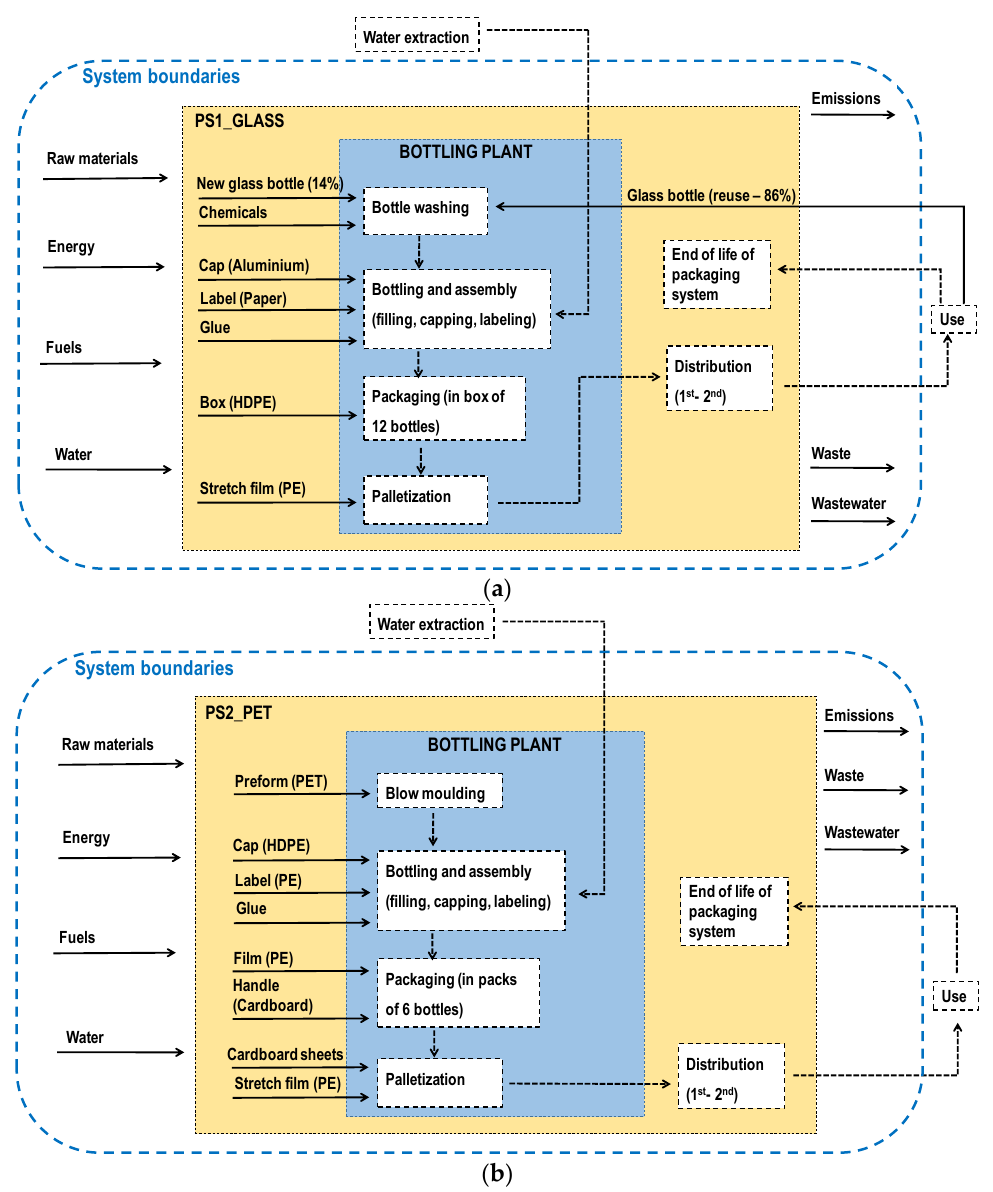
Figure 1. Scheme of system boundaries for the reusable glass bottle packaging system: PS1_GLASS ( a ) and for PET bottle packaging system: PS2_PET (N) and PS2_PET ( b ).